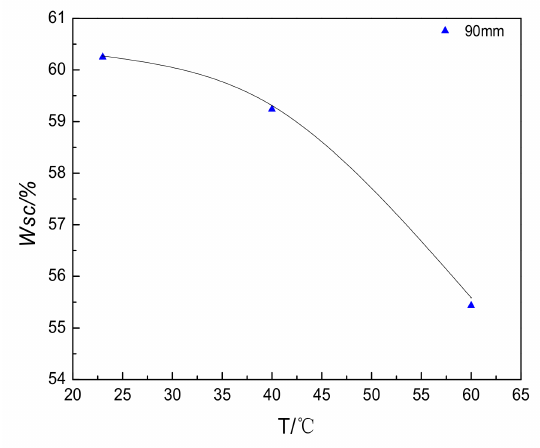
Figure 11. Initial cracking water content curve of red clay at different